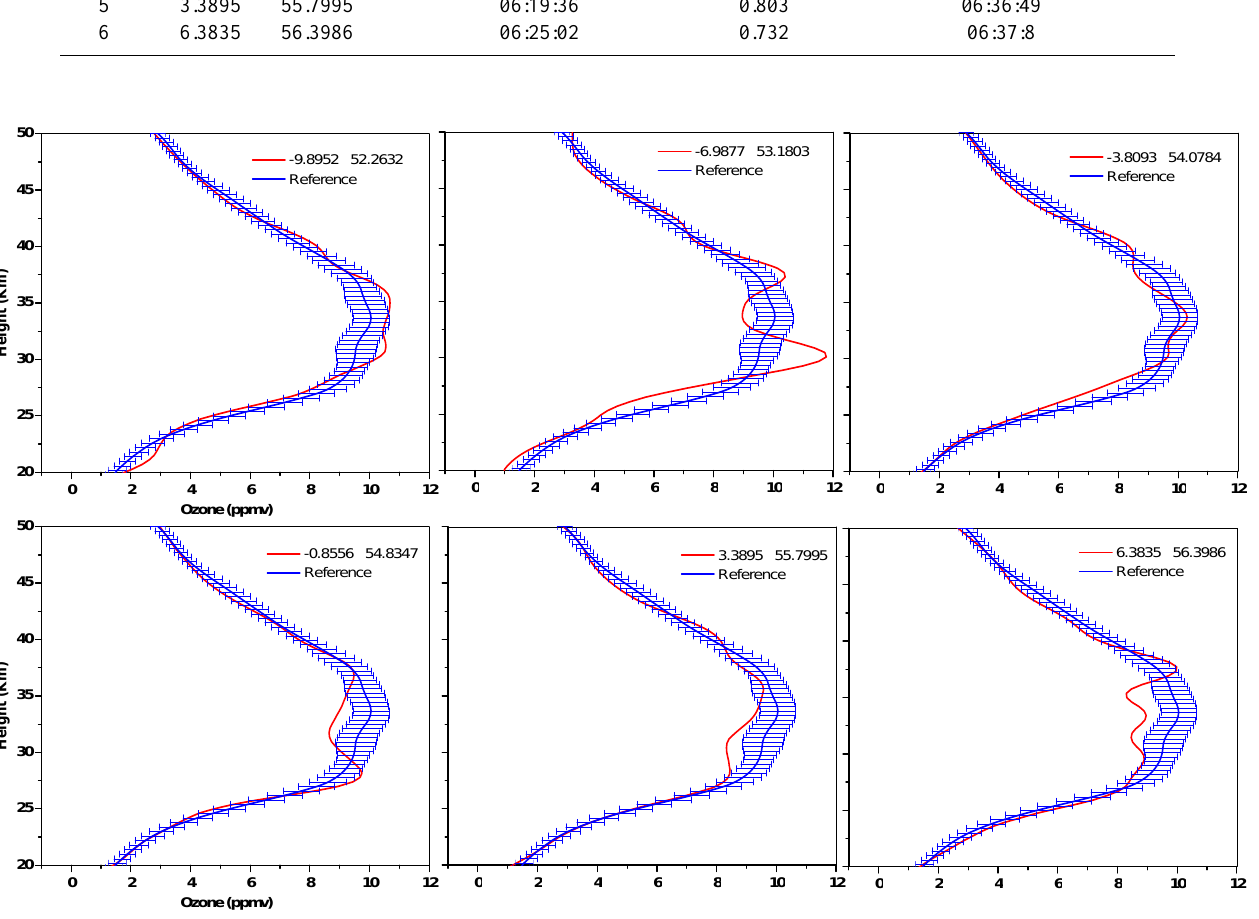
Fig. 2. Height profiles of ozone observed on the eclipse day (red) over the six regions under study along with reference profiles (blue). The horizontal bars in the reference profile indicate the standard